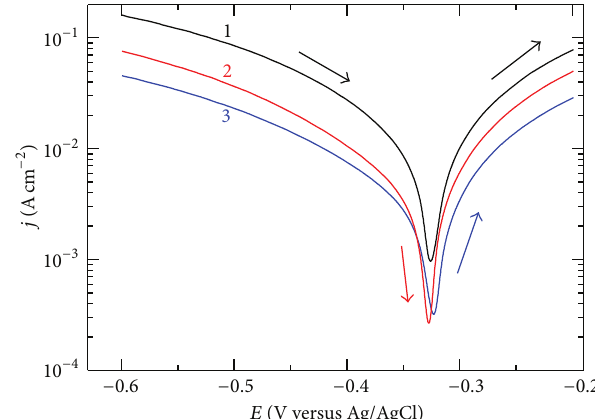
Figure 9: Potentiodynamic polarization curves obtained for the HSLA steel after its immersion for 60min in 2.0 M H 2 SO 4 in the absence(1)andthepresence(2)of1.0 mMATAand(3)5.0 mMATA,